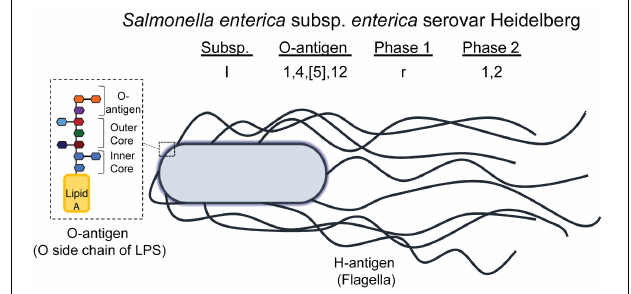
FIGURE 3 | Illustration of NTS O- and H-antigens, comprising the serotyping scheme defined by Kauffman-White-Le Minor. The antigenic formula of a serovar is composed of the subspecies (I -VI), the O-antigen (numbered), and the flagellar antigens called phase 1, phase 2, and phase 3 (if present). Some serovars have lost their phase 1 and/or phase 2 antigen and others have gained additional flagellar antigens (phase 3). The O-antigen illustrated represents the terminal side chain of lipopolysaccharide (LPS) on the cell wall of Gram-negative bacteria, such as Salmonella , which is composed of an inner and outer core of primarily polysaccharides bound to Lipid A; the O side chain is composed of repeating saccharide units, and is the subunit of LPS that differs between serogroups. Salmonella enterica subsp. enterica serovar Heidelberg, the NTS serovar modeled here, is the common name of the serovar having antigenic formula I